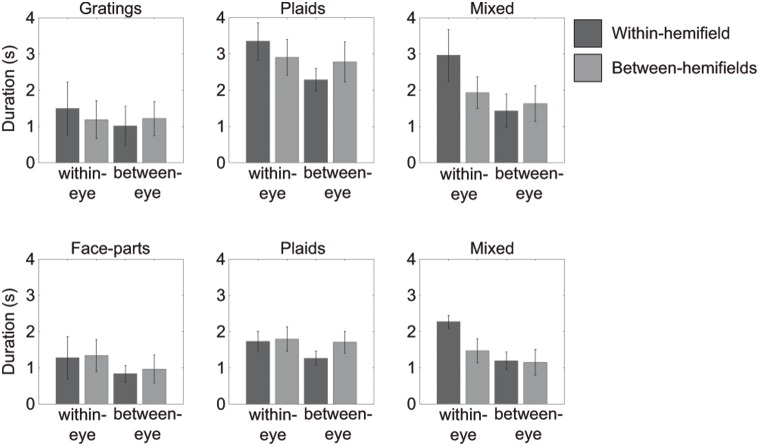
Median percept durations in Experiment 1.Within-hemifield dominance durations are presented in dark grey. Between-hemifield dominance durations are presented in light grey. Error bars represent the 95% confidence intervals. For illustration purposes only, durations were normalized. Each participant’s data was normalized by his or her overall median dominance duration. After averaging across participants the averages were multiplied by the overall median across all participants, which results in a duration in seconds. Note that between-eye dominance of gratings, plaids and face-parts reflects grouping based only on image-content. Within-eye dominance for mixed-percepts reflects grouping based only on eye-of-origin. Within-eye dominance for gratings, plaids and face-parts reflect a combination of eye-of-origin- and image-based grouping.